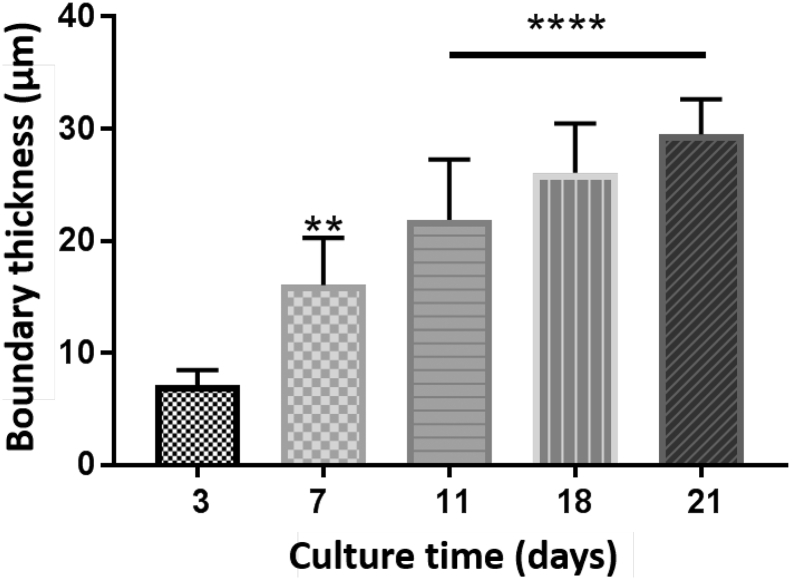
Statistical analysis of peripheral cell thickness.Graph describing spheroid cell perimeter thickness. ImageJ was used to quantify cell-perimeter thickness overtime. There was a time dependent increase in cell perimeter thickness up to 21 days in culture. For the calculation, six areas along the perimeter were measured per spheroid. All spheroid cell perimeters were considered statistically significantly thicker compared to day 3 spheroids by One-way ANOVA **P value < .0022 and ****P value < .0001.